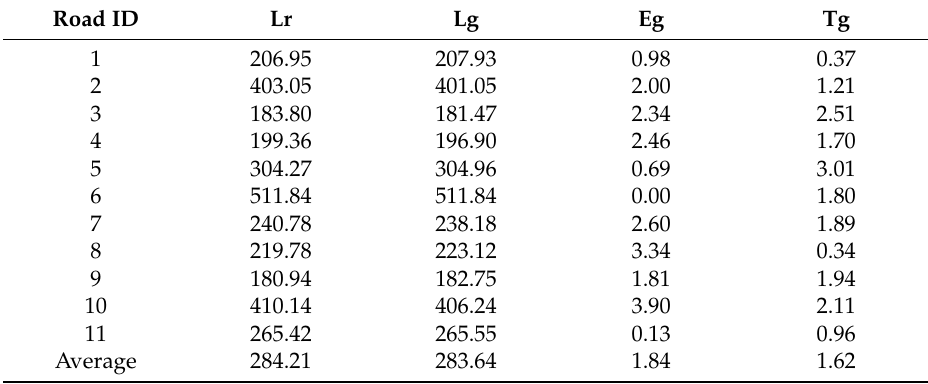
Table 4. Results of the geometric evaluation of generated centerlines (m).